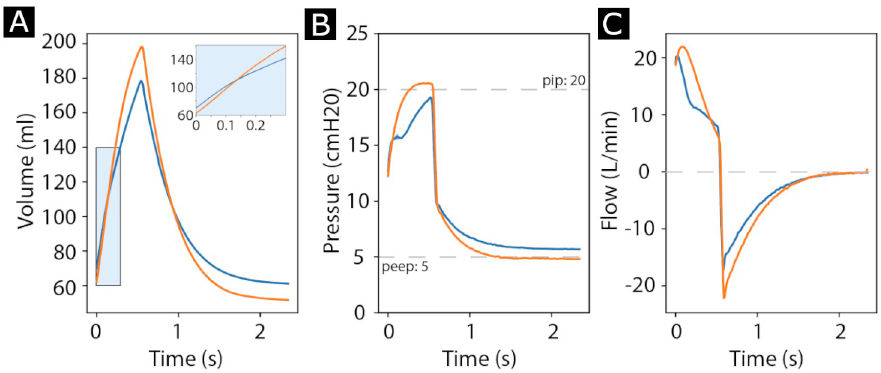
Fig 4. PVP1 performance in a pediatric setting, compared to a Servo-I commercial ventilator. A Volume of delivered air during a breath cycle. Blue is PVP1, Orange is Servo-I. The inset shows a magnified view of the first 0.3 s. Notice how the increase in volume is more rapid in PVP1 when compared to the commercial system. B Pressure waveforms produced by PVP1 and Servo-I. Dashed lines indicate target PEEP and PIP. C Flow in and out of the lung produced by both systems. For all three plots, we set the breath rate to 25 breaths per minute, PEEP to 5 cmH 2 O, PIP to 20 cmH 2 O, and inspiration time to 0.6 s. The pediatric lung settings were R = 25 cmH 2 O/L/s and C = 10 ml/cmH 2 O with an uncompensated residual capacity of 400 ml.